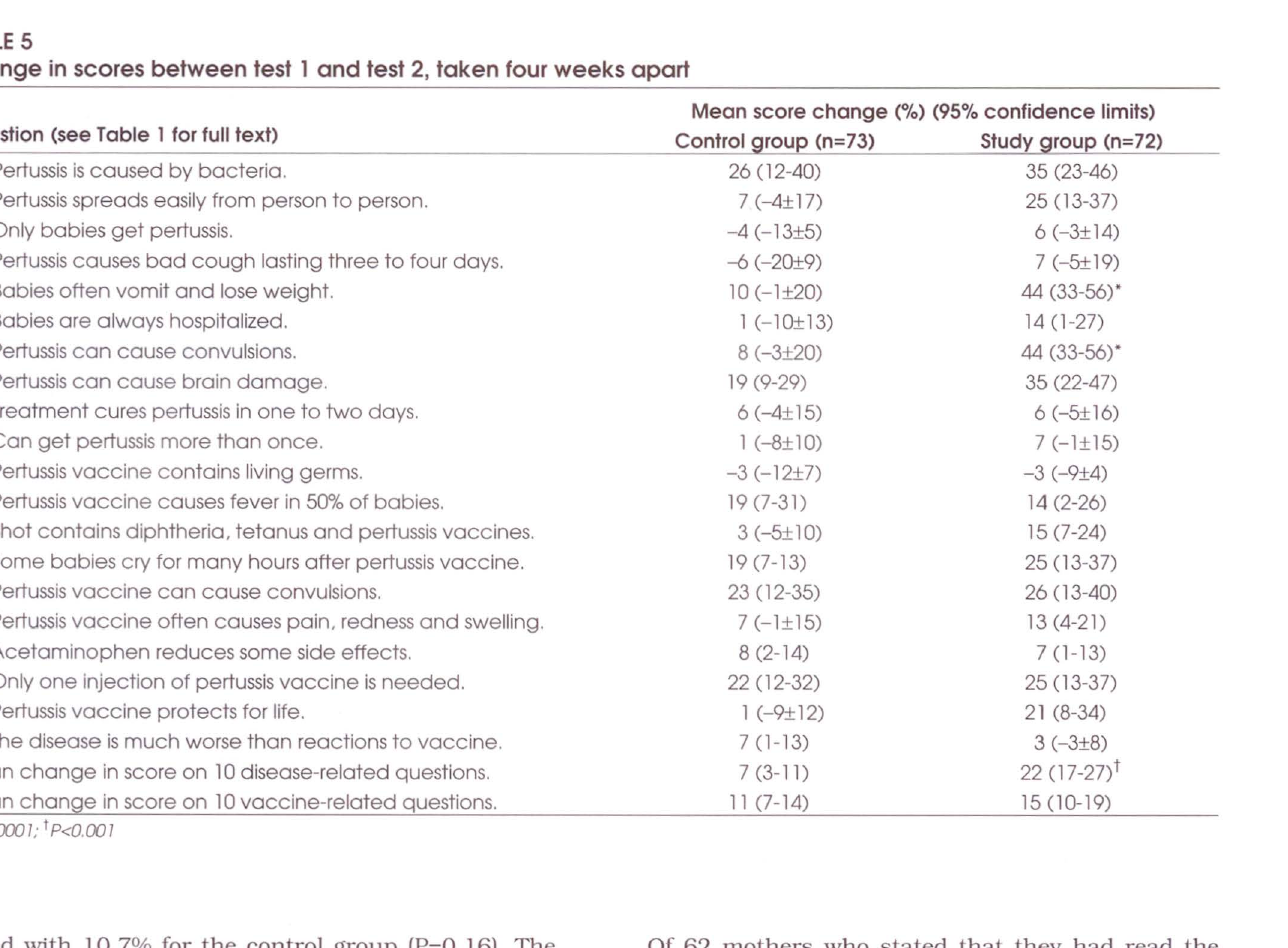
Change in scores between test 1 and test 2, taken four weeks apart Question (see Table 1 for full